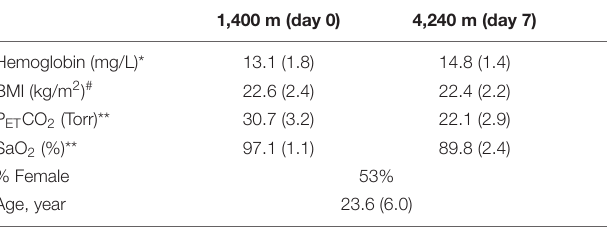
TABLE 1 | Participant